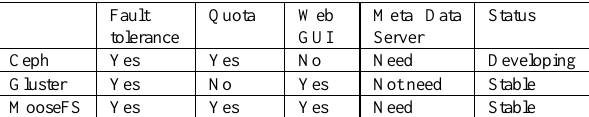
Table 1. The comparison of distributed file systems